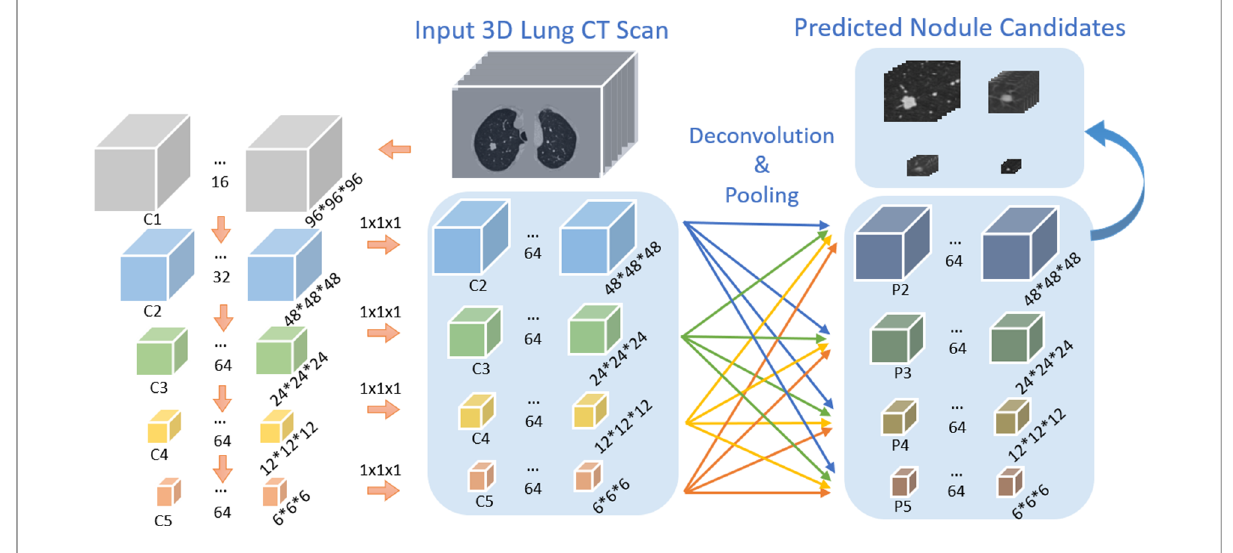
FIGURE 3 Architecture of our proposed 3DFPN network. The input 3D volume is split into 96 (cid:1) 96 pixels (cid:1) 96 slices. The size of C1, C2, C3, C4, C5 is 96 3 , 48 3 , 24 3 , 12 3 , and 6 3 respectively. The following convolution layer with kernel size 1 (cid:1) 1 (cid:1) 1 converts feature channels to 64 dimensions. 3D deconvolution and max-pooling layers are applied for integrating each of the convolution layers C2, C3, C4, C5 to the pyramid layers P2, P3, P4,